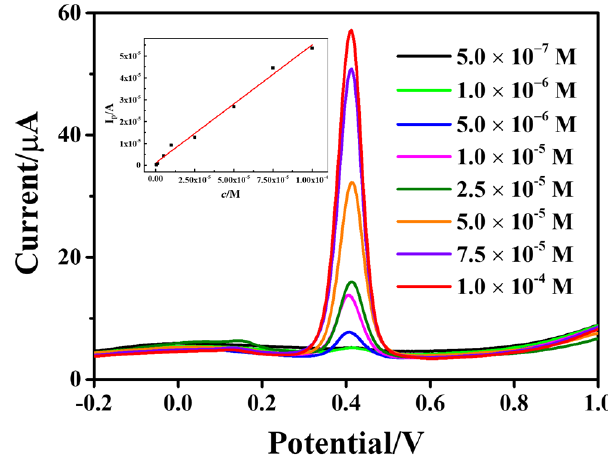
Figure 8. SWV curves of AC on Fe 3 O 4 -rGO/GCE electrodes at different concentrations from 5 × 10 − 7 to 1 × 10 − 4 M (The inset shows the standard curve of AC concentration with respect to peak current).